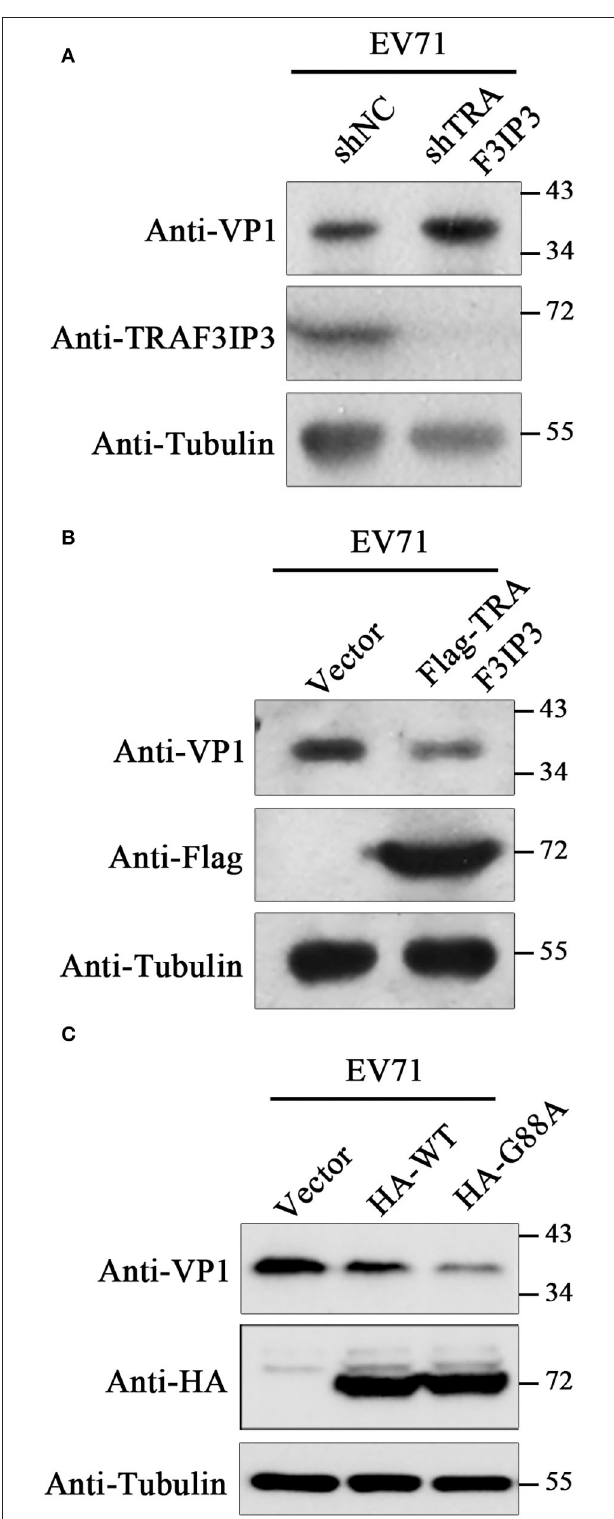
FIGURE 4 | TRAF3IP3 inhibits EV71 replication. (A) Jurkat cells were first infected with lentiviruses expressing negative control shRNA (shNC) or an